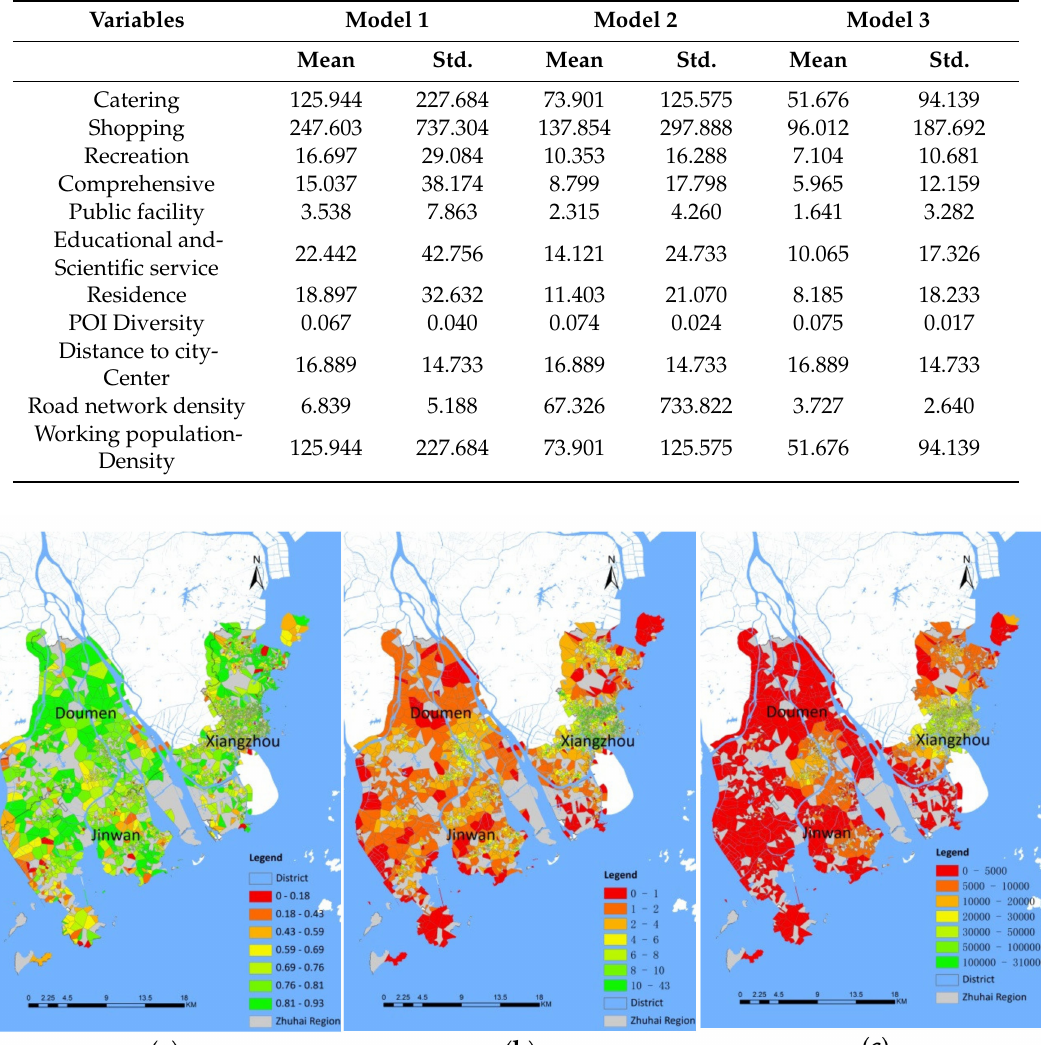
Table 3. Descriptive statistics of independent variables.